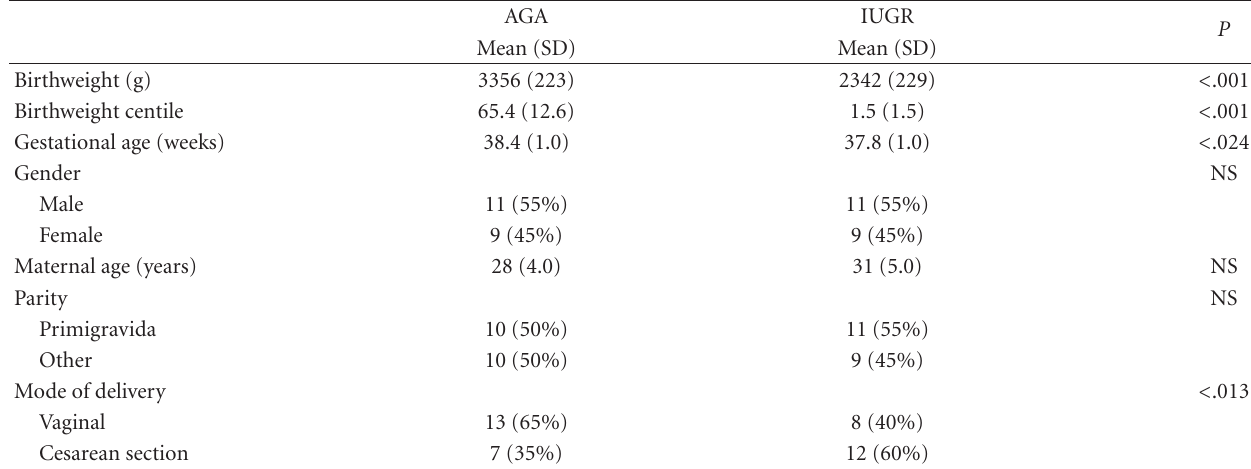
Table 1: Demographic data for AGA and IUGR neonates and their